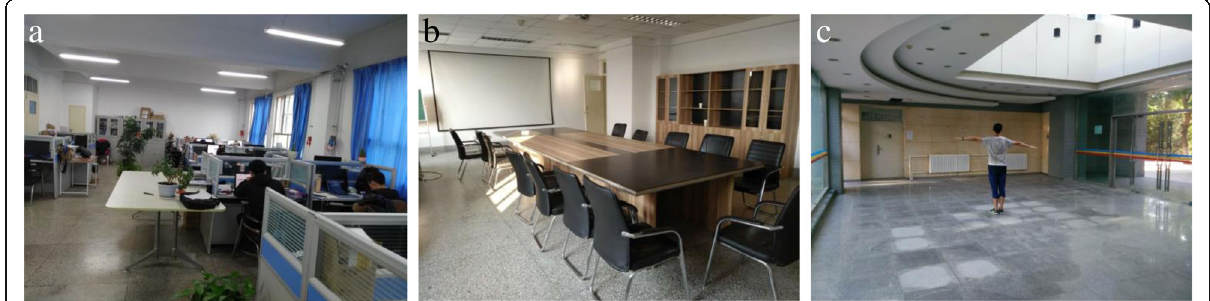
Fig. 7 The testbeds: the laboratory and meeting room and hall. a Laboratory. b Meeting room. c